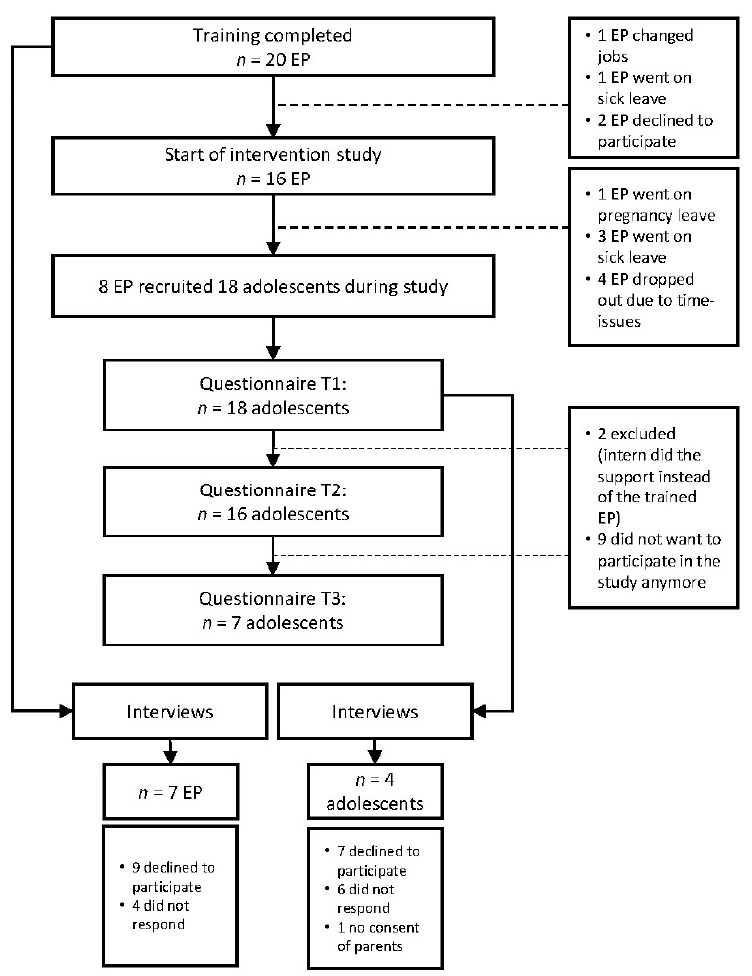
Figure 1. Participant Flow Chart